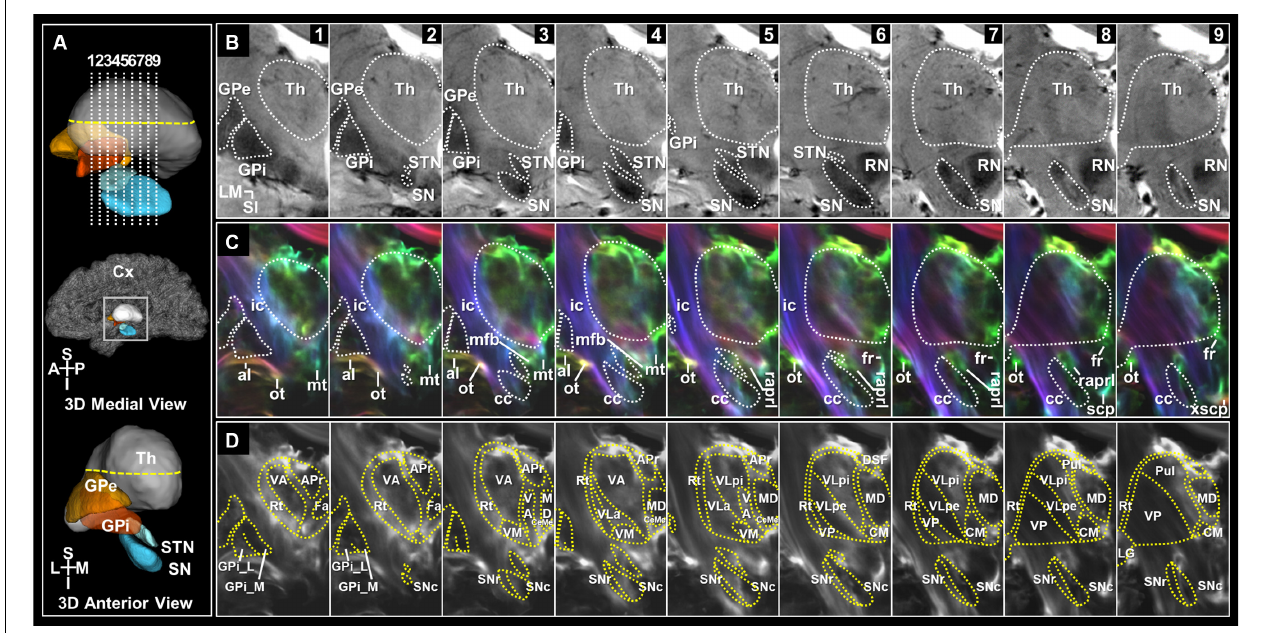
FIGURE 2 | Coronal sections of the deep brain regions and surrounding WM tracts in the super-resolution TDI maps. (A) Slice levels shown in a 3D representation of the deep brain regions with imaging locations shown from a midsagittal view (top). 3D model of those shown from an anterior view (bottom). (B) The coronal view images of the deep brain on T2*-weighted MRI at 7T in serial 2 mm sections from anterior to posterior levels. (C) Super-resolution DEC-TDI maps of the deep brain regions and surrounding WM structures. Fiber-directionality information was incorporated as red (right-left)–green (anterior-posterior)–blue (superior-inferior). (D) Super-resolution TDI maps tracing the substructures of the thalamus and BG in selected slices. Anatomical annotations based on the stereotactic atlas by Mai (Mai et al., 2008). al, ansa lenticularis; APr, anteroprincipal nucleus; cc, crus cerebri; CeMe, central medial nucleus; CM, centromedian nucleus; Cx, Cortex; DSF, dorsal superficial nucleus; Fa, fasciculosus nucleus; fr, fasciculus retroflexus; GPe, globus pallidus, external segment; GPi, globus pallidus, internal segment; GPi_L, GPi lateral part; GPi_M, GPi medial part; ic, internal capsule; LG, lateral geniculate nucleus; MD, mediodorsal nucleus; mfb, medial forebrain bundle; mt, mammillothalamic tract; ot, optic tract; Pul, pulvinar; raprl, prelemniscal radiation; RN, red nucleus; Rt, reticular nucleus; scp, superior cerebellar peduncle; SN, substantia nigra; SNc, SN pars compacta; SNr, SN pars reticulata; STN, subthalamic nucleus; Th, thalamus; VA, ventral anterior nucleus; VLa, ventral lateral